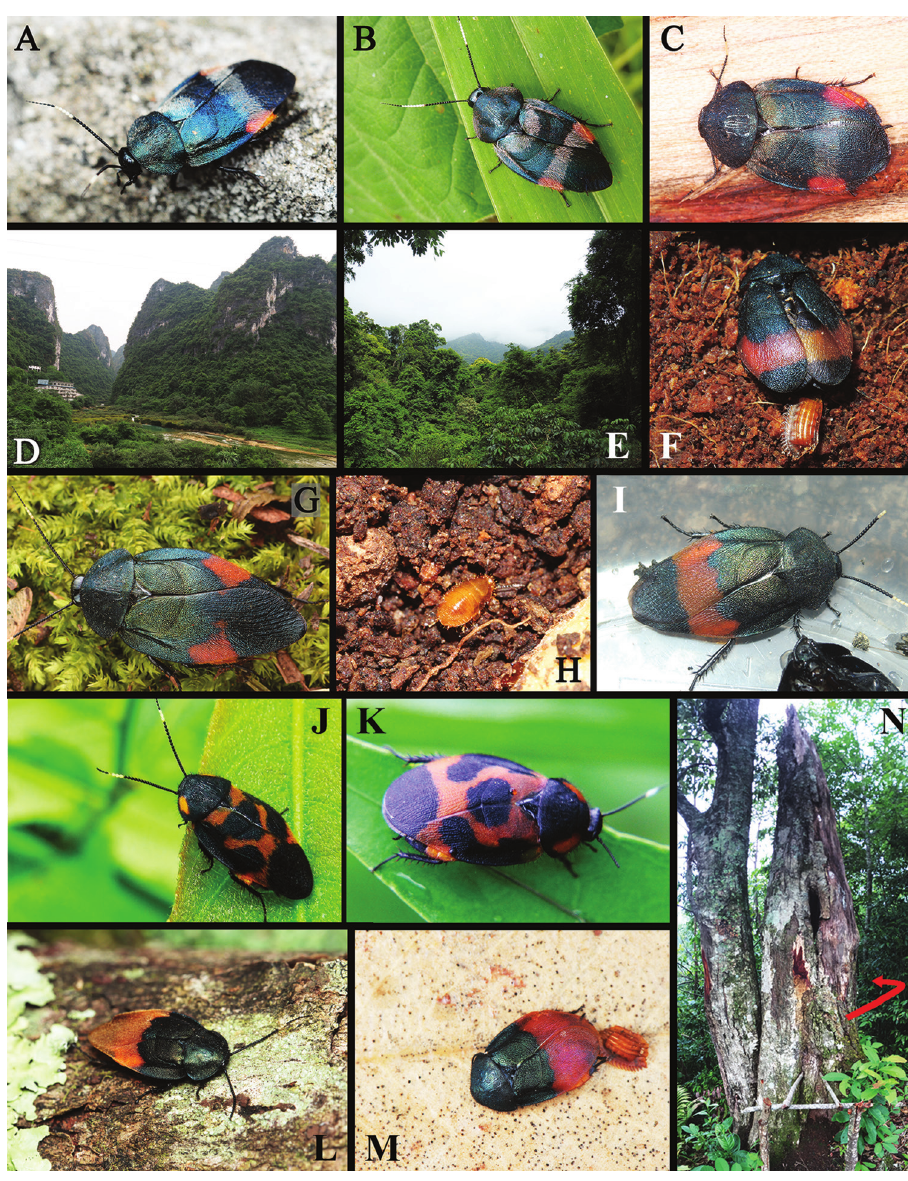
Figure 14. A–D habitats of E. linglong sp. n.: A male, Manhao, Yunnan B male, Cuc-Phuong Na- tional Park , Vietnam C female, Shuolong, Guangxi D environment in Shuolong, Guangxi E–I habitats of E. dasytoides : E habitat in Mingfenggu, Mt. Jianfengling, Hainan F a female with ootheca under lab conditions G a male from Taiwan H a nymph under lab conditions I a newly captured male from Mt. Jian- fengling J–K E. ornata from India: J male from Madhya Pradesh K female from Maharashtra L–N habitats of E. hilaris : L male from Lvchun, Yunnan M–N newly-collected female and the tree where captured, Pu’er, Yunnan [Photograph A by Jin Chen; B by Eduard Jendek; C by Ye Liu; D by Yi-Zhou Liu; G by Dash Huang; J–K by Aniruddha Dhamorikar; L by Jian-Yun Wang; M–N by Chao Li; the rest by Lu